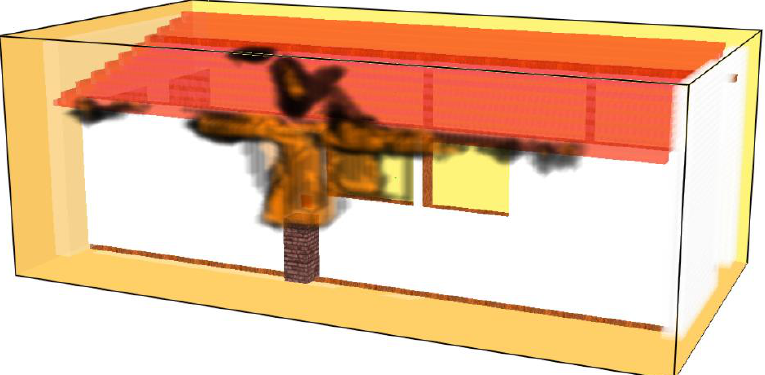
Figure 14. The spread of the fire on the outside of the eastern wall of the floor, favored by the combustible properties of the polystyrene insulation.